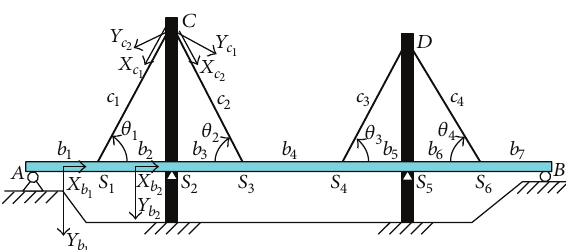
Figure 1: Schematic of a cable-stayed bridge that consists of a simply supported four-cable-stayed deck beam and two rigid